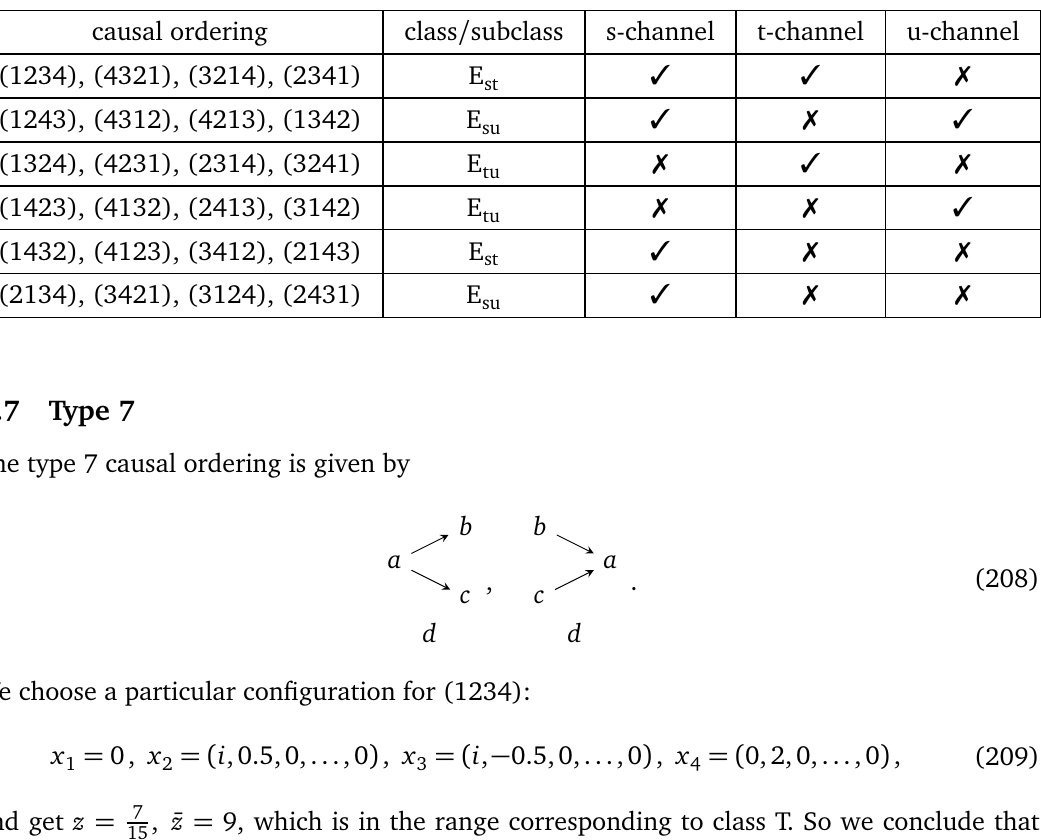
Table 10: OPE convergence properties of type 6 causal orderings